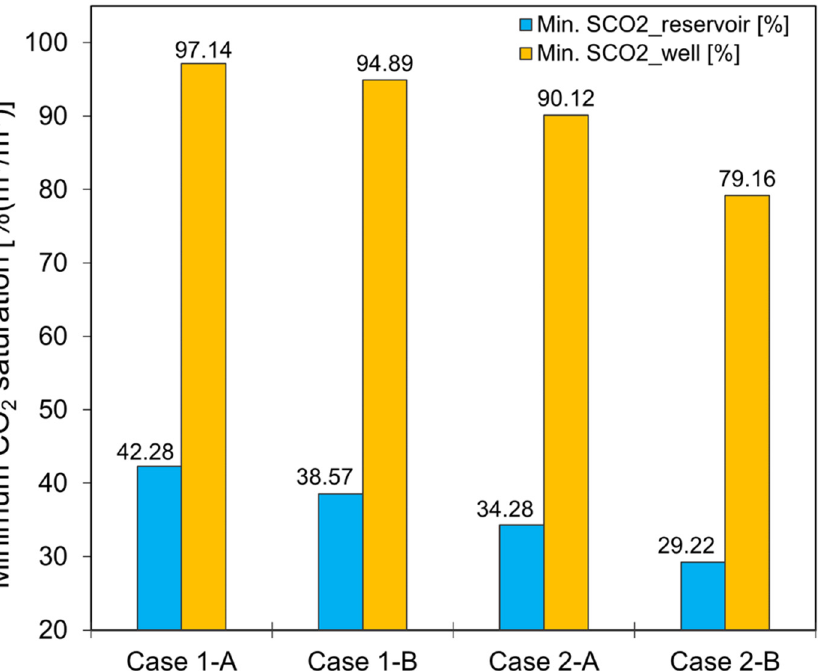
Figure 2. Simulation results for partially depleted (case 1) and depleted (case 2) natural gas reservoirs